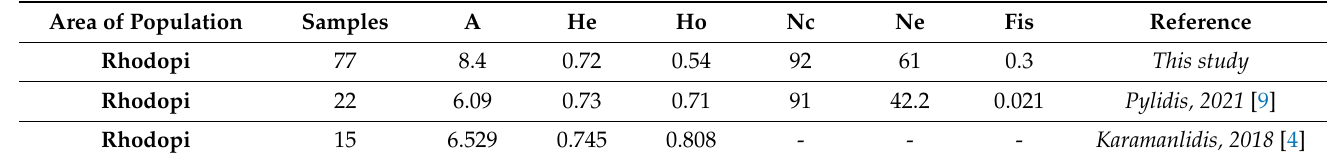
Table 11. Comparative table with studies carried out in Rhodopi (number of alleles (A); expected heterozygosity (He); observed heterozygosity (Ho); census population size (N C ); effective population size (Ne); inbreeding coefficient